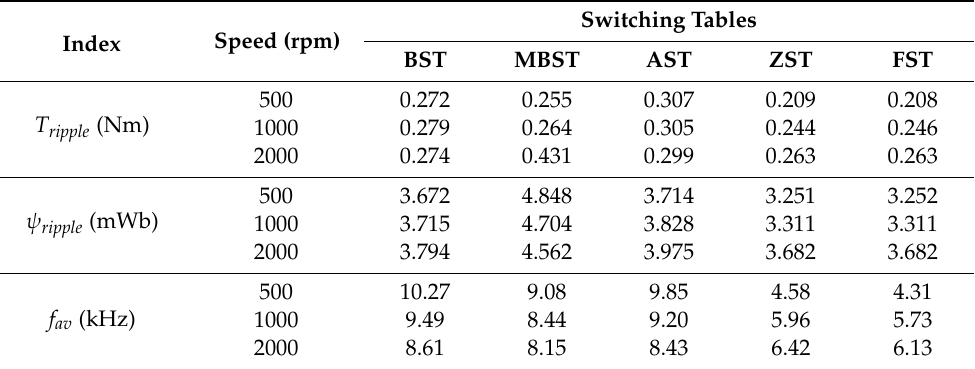
Table 3. Quantitative comparison of the STs under di ff erent operating